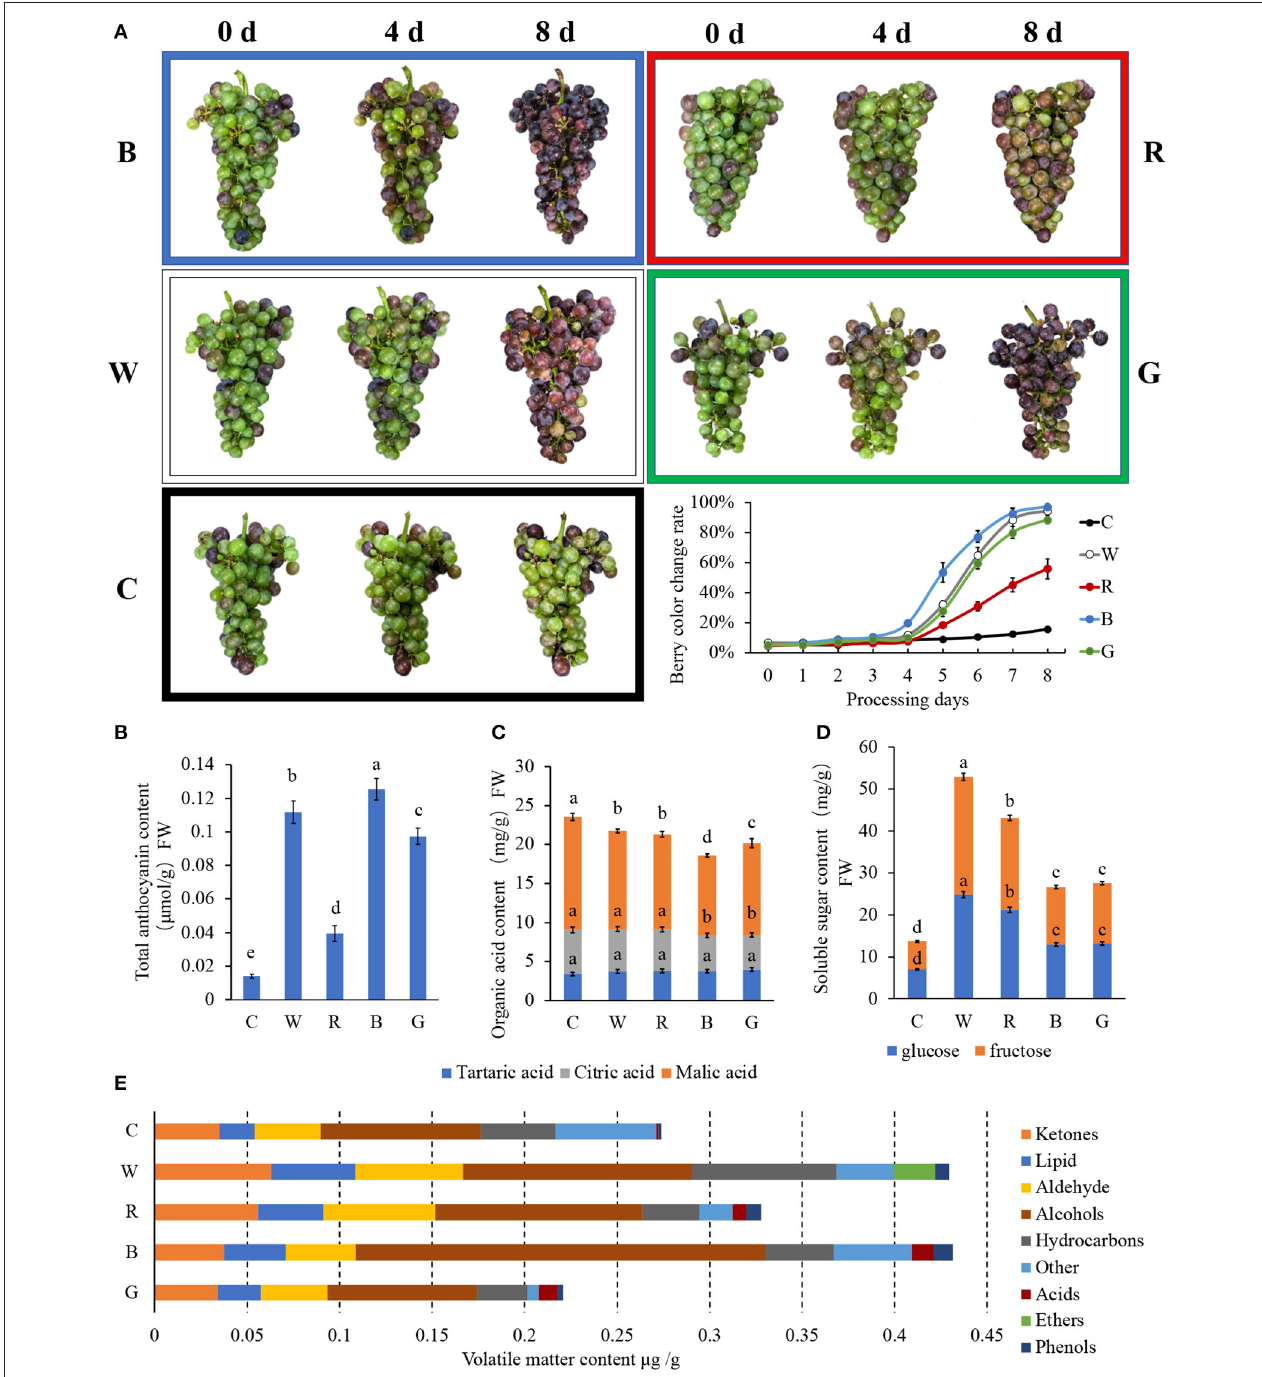
FIGURE 1 | Physiological characteristics of “Cabernet Sauvignon” after different light quality LED treatments. The effects of different light quality treatments on the exterior color (A) , soluble sugar (B) , organic acid (C) , total anthocyanin (D) , and volatiles components (E) content of “Cabernet Sauvignon.” C: control (no light treatment), B: blue light treatment, R: red light treatment, W: white light treatment, G: green light treatment. Vertical bars represent the standard deviation (SD) of the mean ( n = 3). Different letters indicate a significant difference at p < 0.05, as determined by Duncan’s multiple range